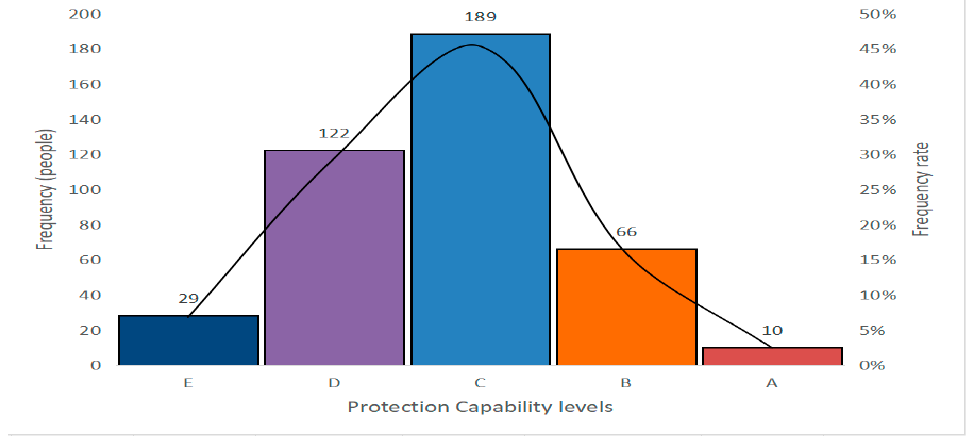
Figure 9. Frequency histogram of privacy protection capability (A–E).